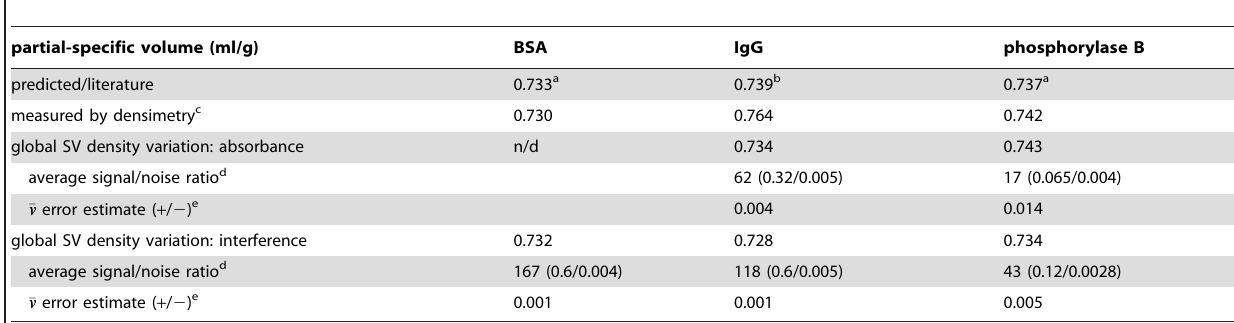
Table 2. Partial-specific volumes obtained for different protein